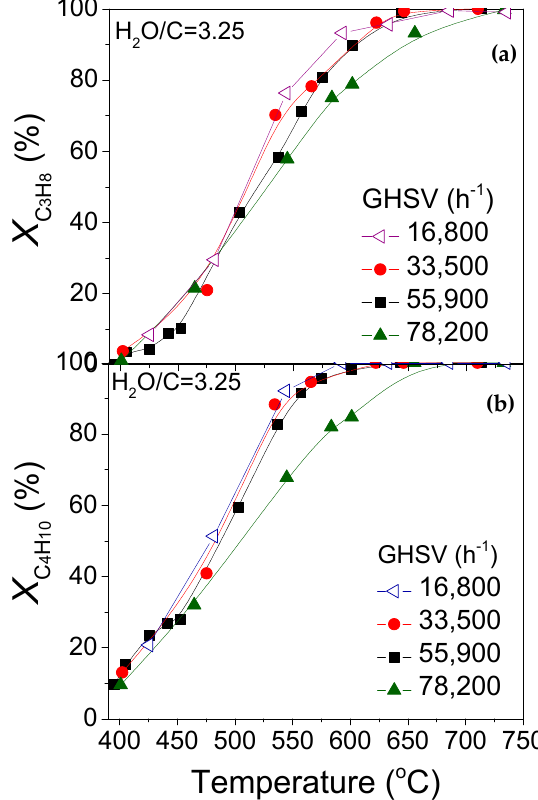
Figure 7. Effect of GHSV on the conversions of ( a ) C 3 H 8 and ( b ) C 4 H 10 obtained as a function of reaction temperature over 0.5%Rh/TiO 2 catalyst. Experimental conditions: H 2 O/C:3.25; particle diameter: 0.15 < d p < 0.25 mm; feed composition: 4.27% C 3 Η 8 , 0.23% C 4 Η 10 , 0.15% Ar, 44% H 2 O (balance He).